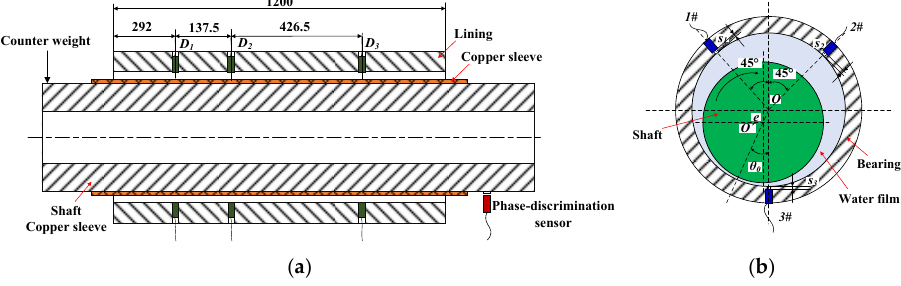
Figure 3. Eddy-current sensor arrangement: ( a ) axial arrangement scheme; ( b ) circumferential arrangement